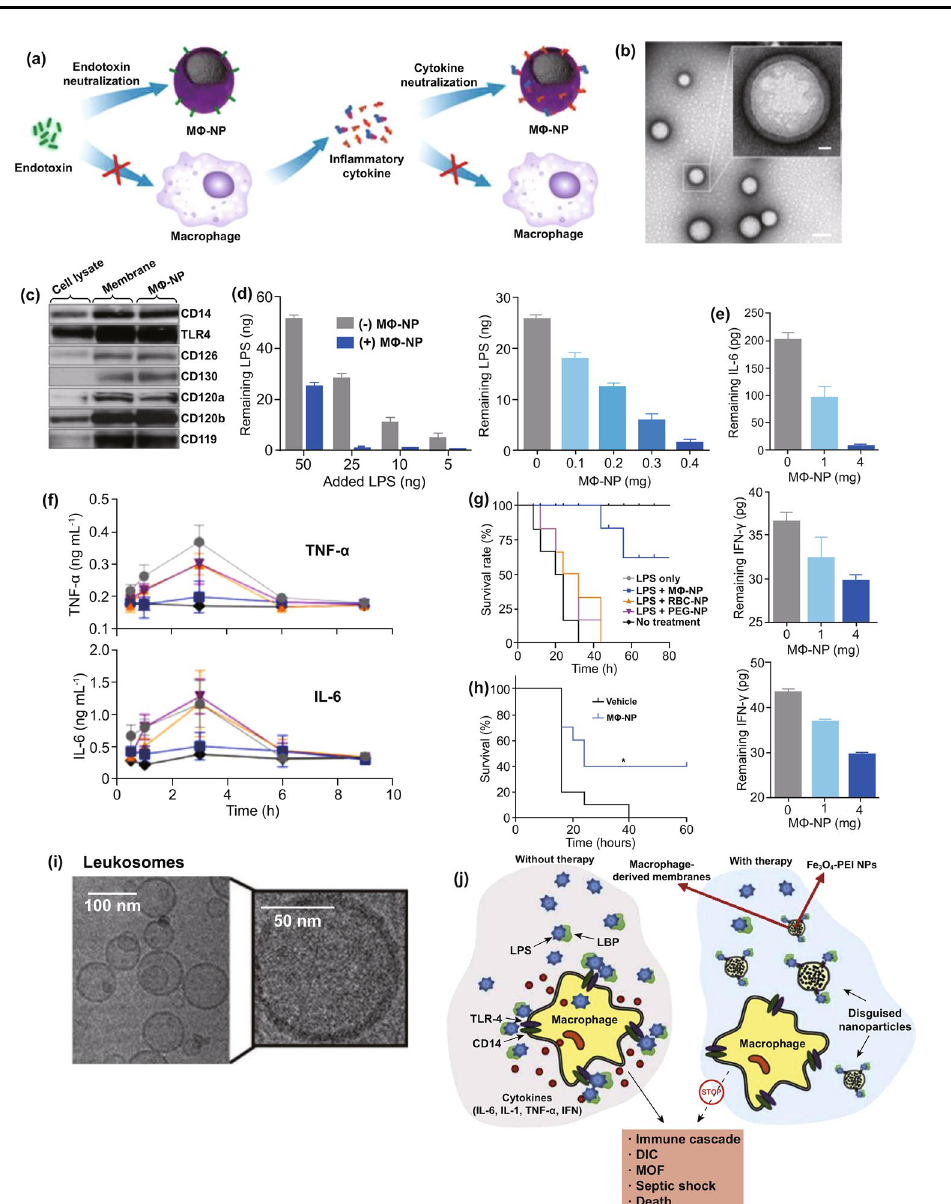
Fig. 16 Macrophage-like nanoparticles with dual endotoxin neutralization and absorption of proinflammatory cytokine functions for sep- sis management. a Schematic illustration of the mechanism for MΦ-NPs as a two-step process to neutralize endotoxins and proinflammatory cytokines for sepsis management. b TEM image of MΦ-NPs (scale bar: 100 nm; scale bar of inset image, 10 nm). c Determination of the expres- sion of macrophage membrane proteins for LPS recognition and cytokine binding using western blotting. d Quantification of LPS removal with/ without fixed MΦ-NP treatment at different amounts of added LPS (left), quantification of LPS removal with different amounts of MΦ-NP treatment at a fixed amount of added LPS (right). e Removal of proinflammatory cytokines, including IL-6, TNF-α, and IFN-γ, using MΦ-NPs. f Dynamics of proinflammatory cytokines, including TNF-α and IL-6, in plasma from LPS-induced septic mice with various treatments. g Sur- vival rates of LPS-induced septic mice with various treatments. h Survival rates of E. coli -induced septic mice with/without MΦ-NPs. Repro- duced with permission from Ref. [234]. Copyright 2017 National Academy of Sciences, U.S.A. i TEM image of leukosomes. Reproduced with permission from ref. [235]. Copyright 2019 Royal Society of Chemistry. j Fe 3 O 4 -PEI NPs coated with macrophage-derived membranes dis- guised as macrophages for LPS neutralization and protecting against sepsis. Reproduced with permission from Ref. [236]. Copyright 2019 Else-